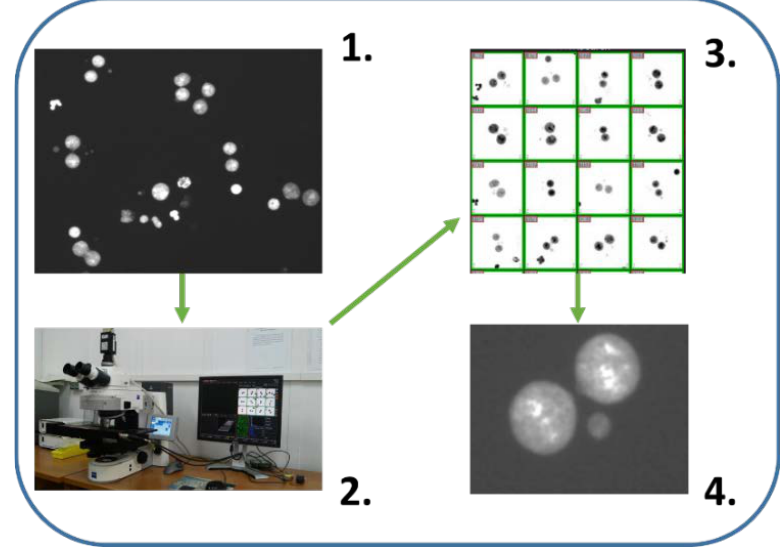
Figure 4. Automatic / semiautomatic scoring by microscope aided systems (Metasystems). (1) Nuclei of cytokinesis-block cells are visible. System recognizes binucleated cells when both nuclei are the same size and they are in proximity to each other. (2) Motorized microscope with image analysis system safe galleries of binucleated cells and recognize Mn in an automatic manner. (3) Gallery of binucleated cells. Mathematical algorithms to recognize binucleated cells implemented in Metasystems has been used many times with good results [55,115,116]. (4) Each cell from the gallery can be localized and e.g., false positive Mn can be verified in high magnification. Such semiautomatic scoring gives better results than automatic scoring.